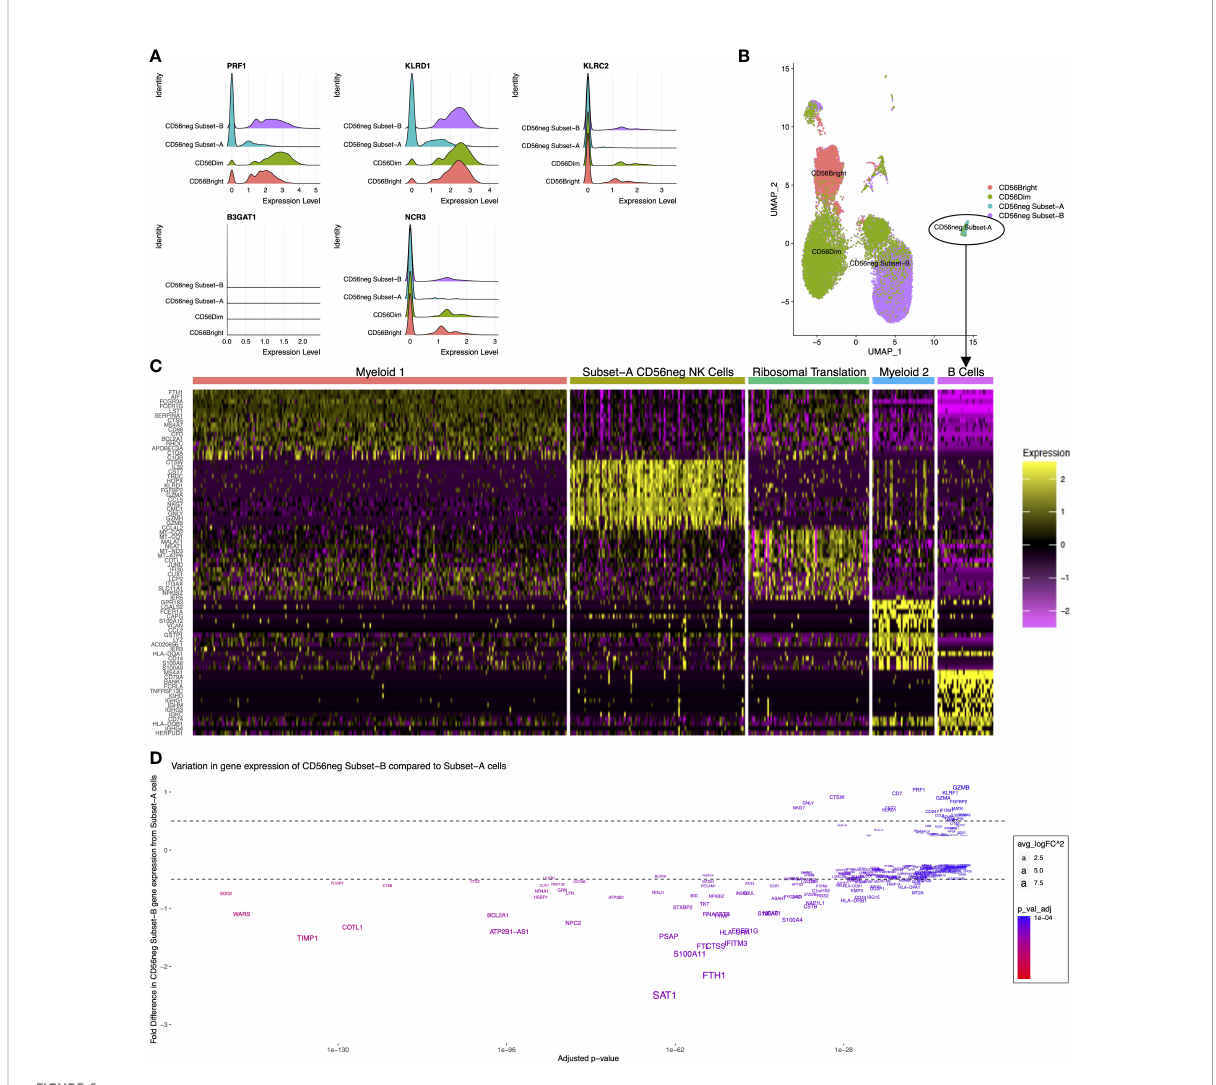
FIGURE 6 Distinct CD56neg subset gene expression. These graphs show the CD56neg cell population from the Bradley 2018 scRNAseq dataset on NK cells from an HIV-1 + donor (24). (A) histograms of NK cell subset gene expression of perforin ( PRF1 ), CD94 ( KLRD1 ), NKG2C ( KLRC2 ), CD57 ( B3GAT1 ), and NKp30 ( NCR3 ). (B) UMAP of CD56bright, CD56dim, and CD56neg meta-clusters. (C) top fi fteen differentially expressed genes for the 5 clusters identi fi ed within CD56neg Subset-A. One cluster demonstrated NK cell gene expression including CD7 , NKG7 , GNLY , and granzyme genes. Other clusters had myeloid, B-cell, or ribosome-associated transcriptomes. (D) variation in gene expression of Subset-B CD56neg cells compared to the NK cell cluster within the Subset-A CD56neg subset. Adjusted p-values for differential gene expression level are shown on the x-axis, and the fold difference in expression of Subset-B cells to Subset-A on the y-axis. Gene name sizes correspond to their fold difference in expression, and the level of signi fi cant difference between subsets is shown by increasing red